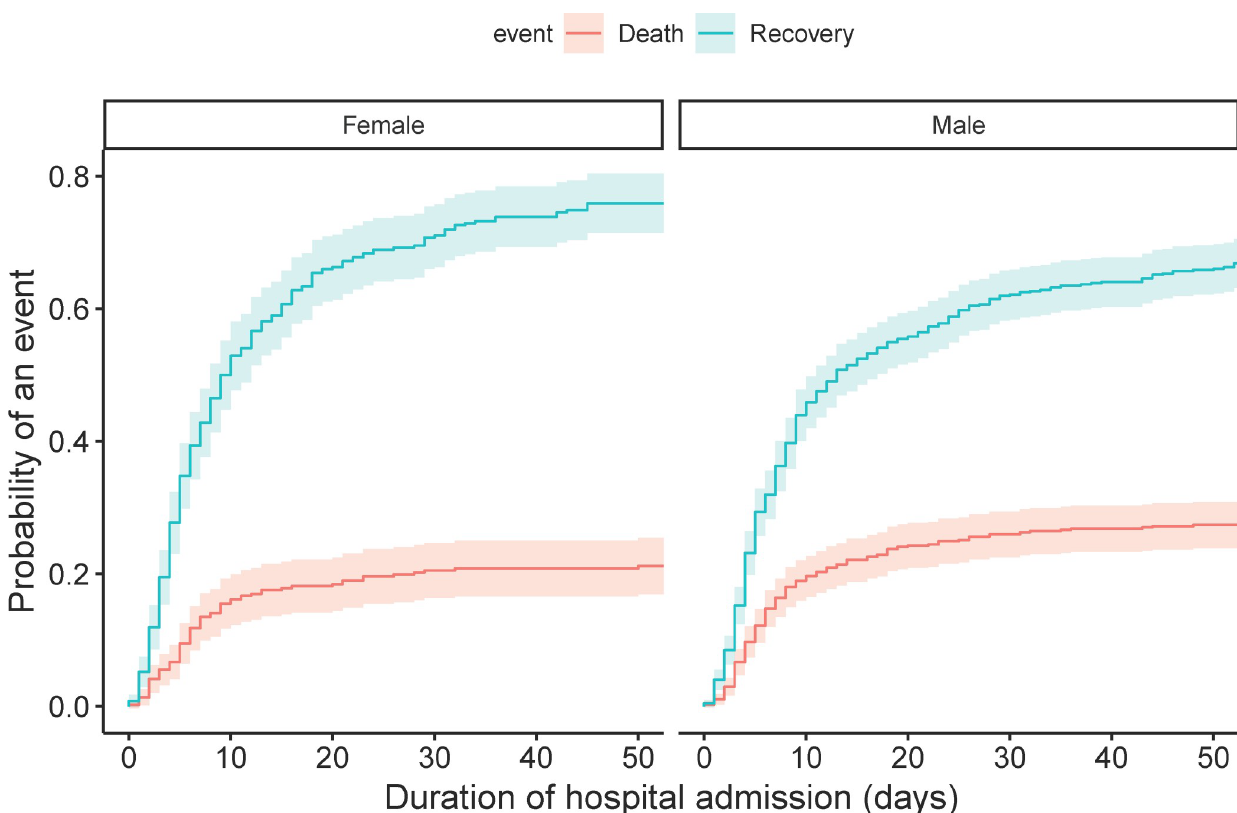
Fig 3. Cumulative incidence plot of death and recovery in the total population, separated by sex. Gray’s test indicated a statistically significant difference between both groups for recovery (p = 0.003), but not for death (p = 0.050). The probability of death for females after one, two and three weeks of hospital admission was 12.5% (95% CI 10.0–17.1), 17.6% (95% CI 13.7–21.6), and 19.1% (95% CI 15.0–23.2), respectively, whereas for males the probability of death was 16.4% (95% CI 13.5–19.3), 22.1% (95% CI 18.9–25.4), and 24.3% (95% CI 20.9–27.6),